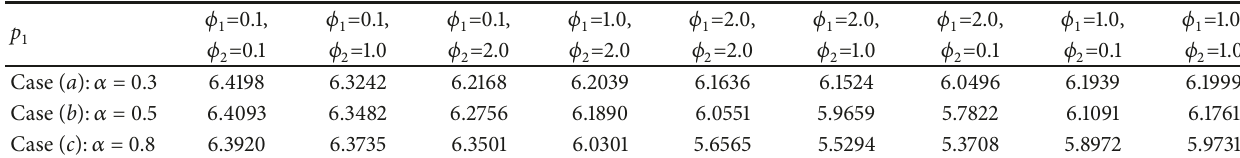
Table 1: The impact of fairness concern on player 1’s price p 1 under three cases.